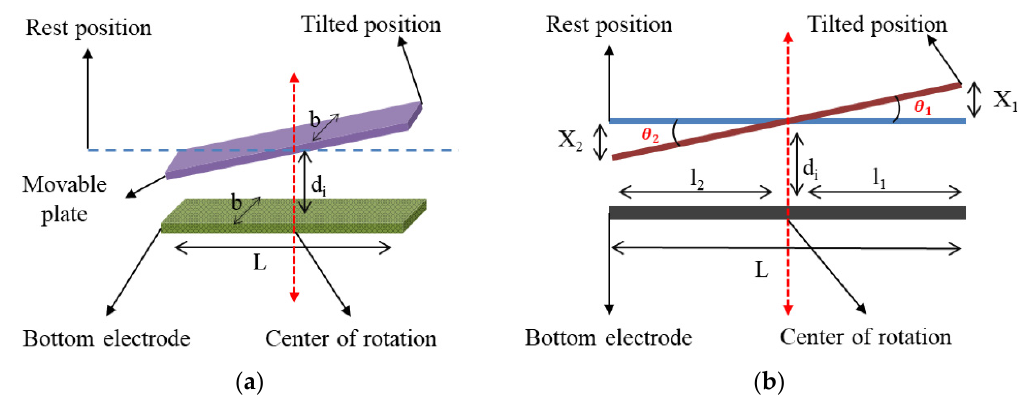
Figure 5. Inclined Plate Capacitor in Tilted Position. ( a ) Schematic View of Inclined Capacitor; ( b ) Free Body Diagram of Inclined Capacitor.